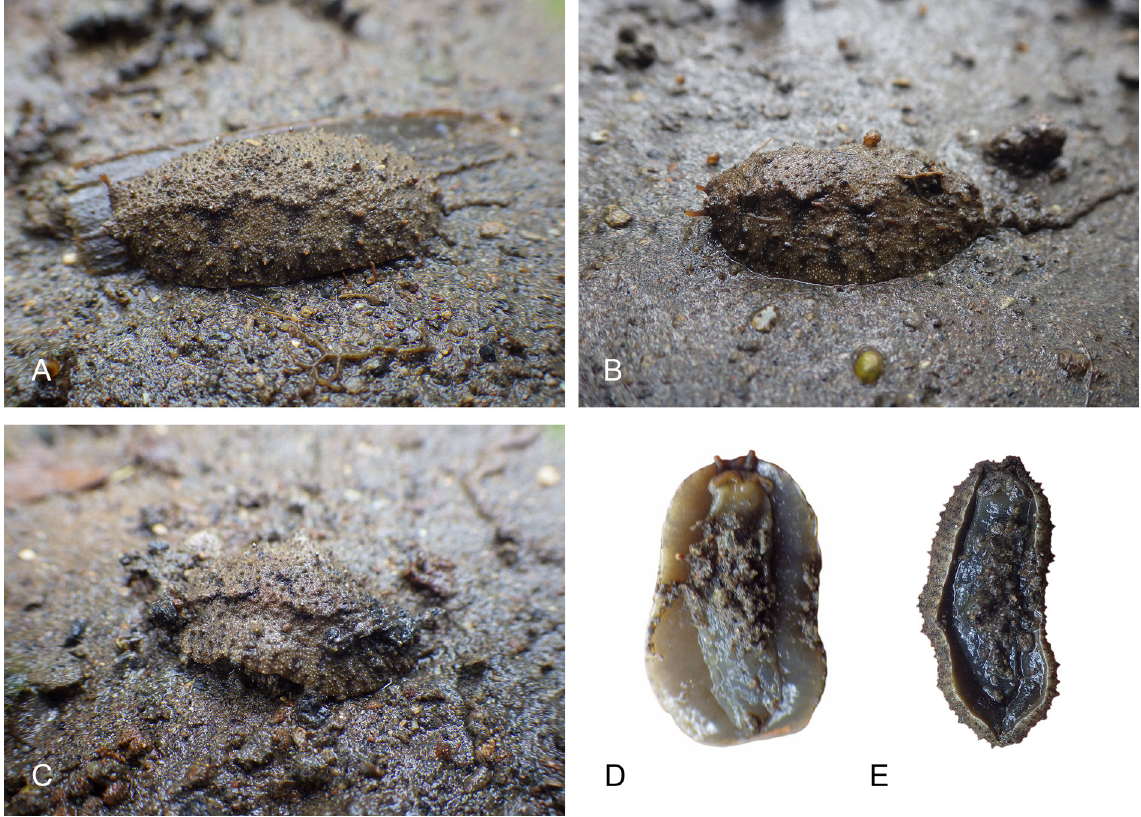
Fig. 45. Paromoionchis goslineri gen. et sp. nov. unit #1, live animals, Philippines, Luzon. A . Dorsal view, 30 mm long [3232] (PNM 041273). B . Dorsal view, 22 mm long [3221] (PNM 041272). C . Holotype, dorsal view, 25 mm long [3233] (PNM 041271). D . Ventral view, same as B. E . Ventral view, same as